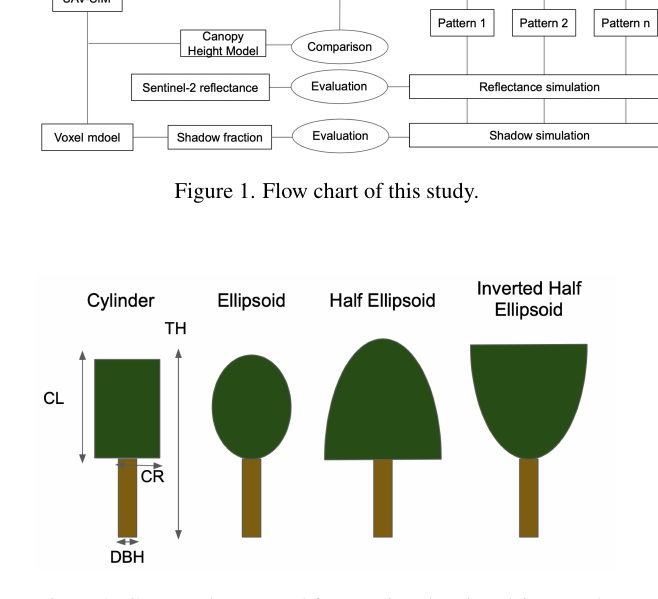
Figure 2. Canopy shapes used for creating the virtual forest. The canopy structure is Tree Height (TH), Canopy Length (CL), Canopy Radius (CR) and Diameter at Breast Height